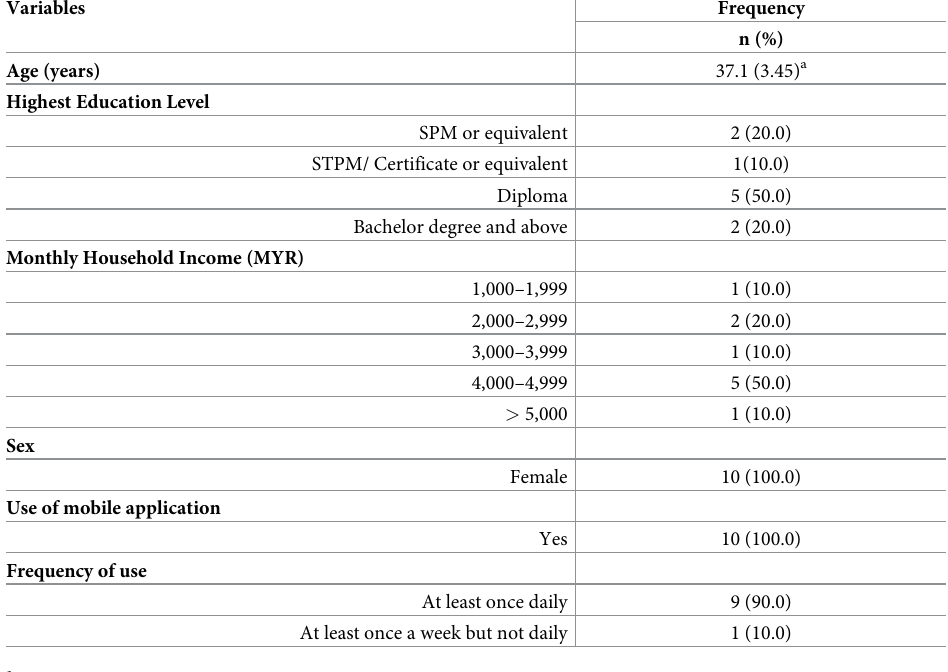
Table 4. Sociodemographic characteristics of beta-testers (n =